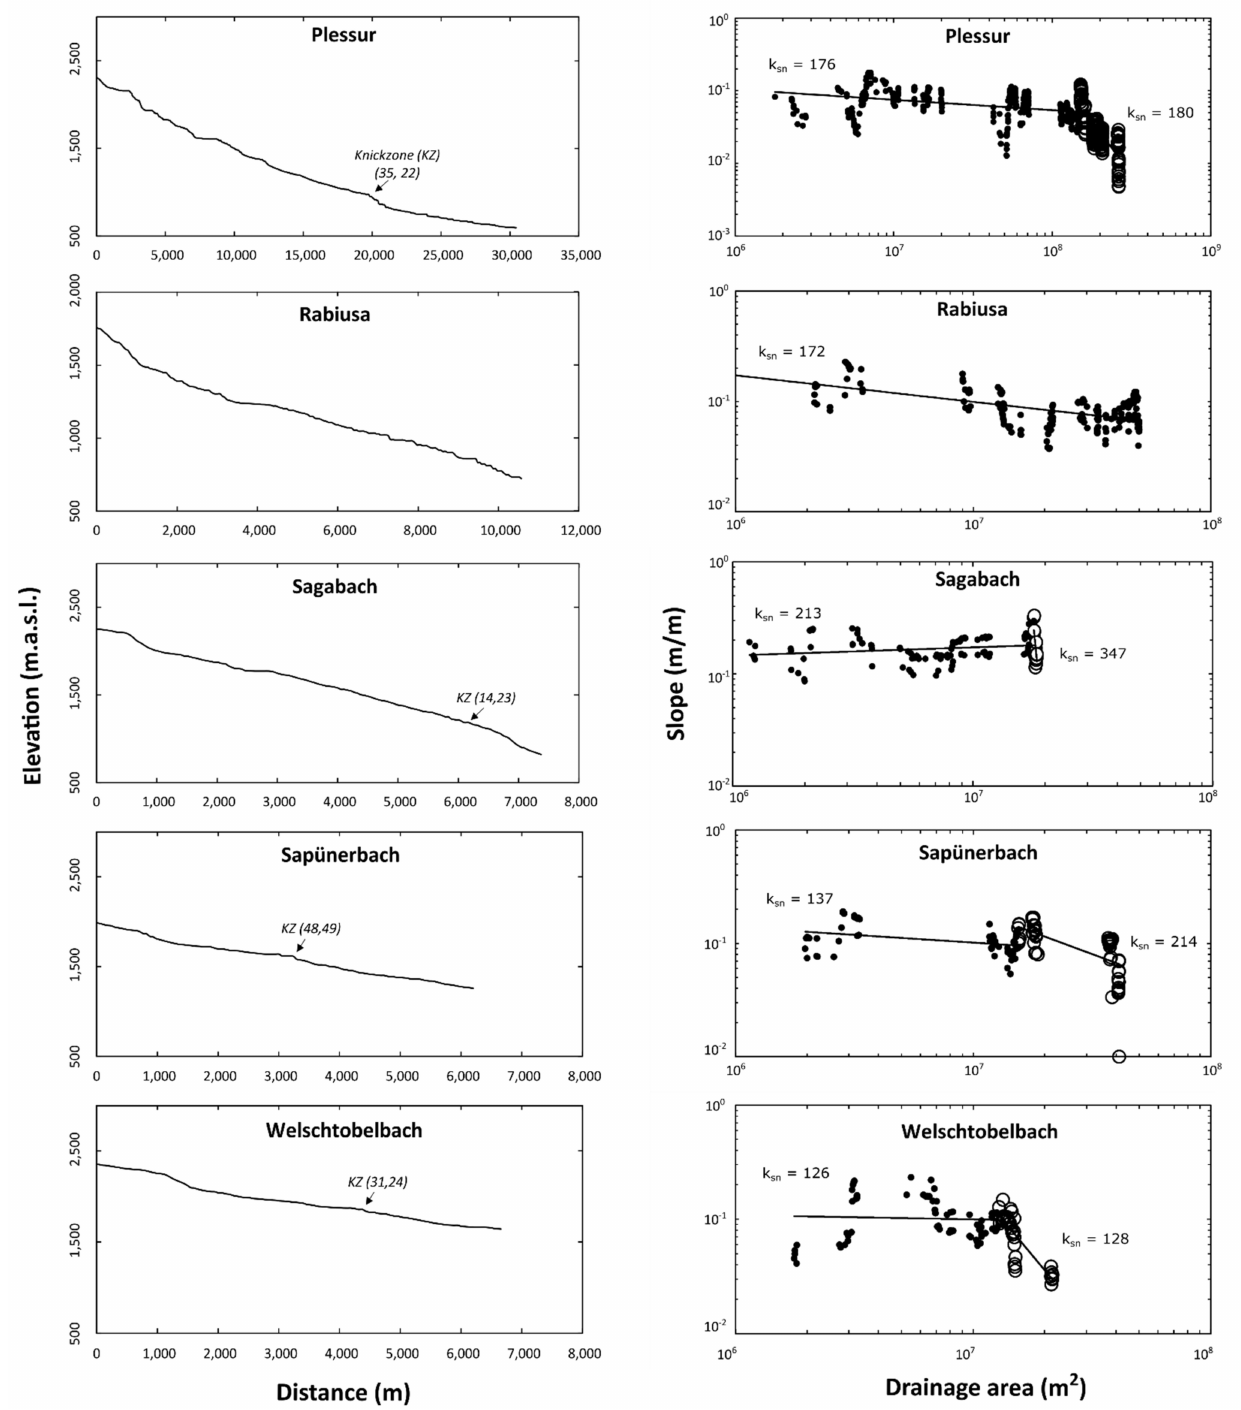
Figure 5. Longitudinal stream profiles of the Plessur River and main tributaries and respective normalized steepness index plots. Knickzones (KZ) are identified in the stream profiles. The KZ horizontal and vertical relative propagation are indicated as percentages, respectively. Refer to Table 1 for the